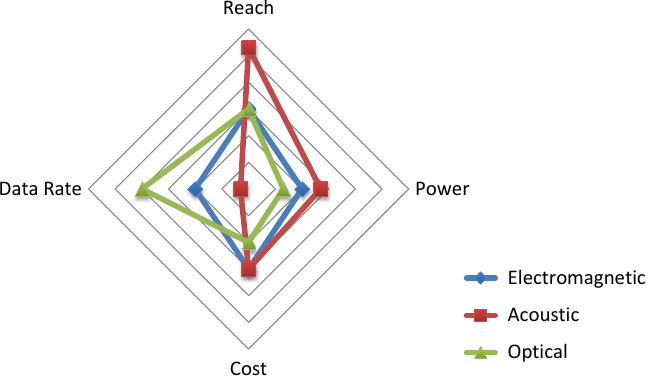
Figure 6. Comparison of electromagnetic, acoustic, and optical underwater wireless sensor networks [69].